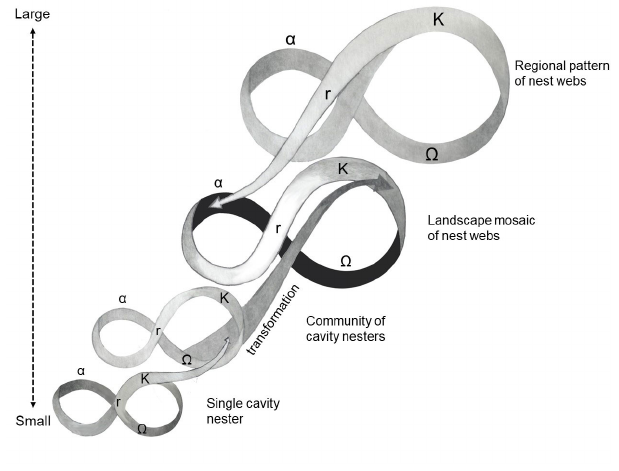
Fig. 3 . In this panarchy model of nest web patterns and processes interacting across spatial and temporal scales, the continuous reshuffling within adaptive cycles at each level, and the constant feedback across levels, allows the nest web to constantly adapt and evolve to the changing conditions of forests around the world (see Table 1 for